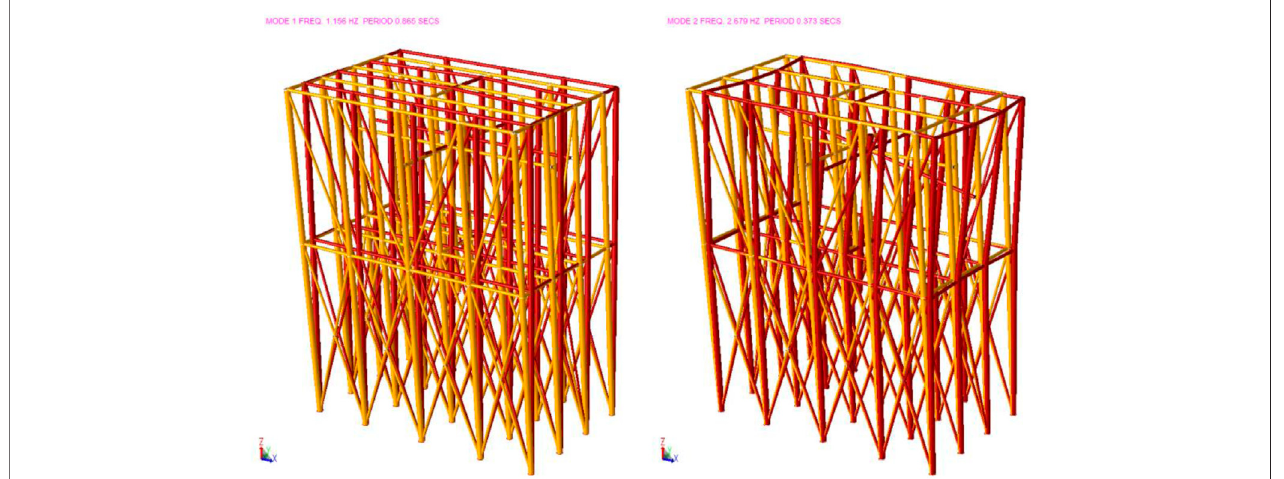
FIGURE 7 | Diagram of the fi rst- and second-order modes of the simpli fi ed model.